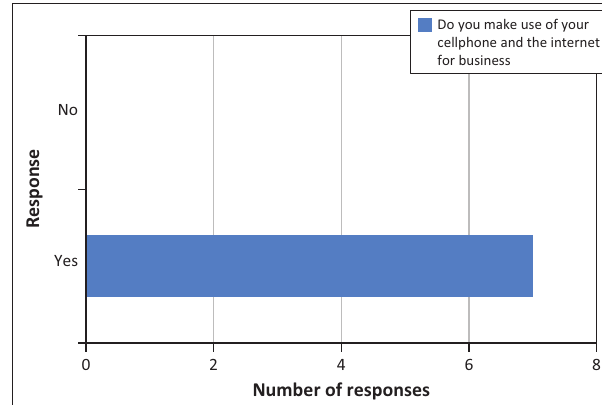
FIGURE 5: Access to business advice and support.